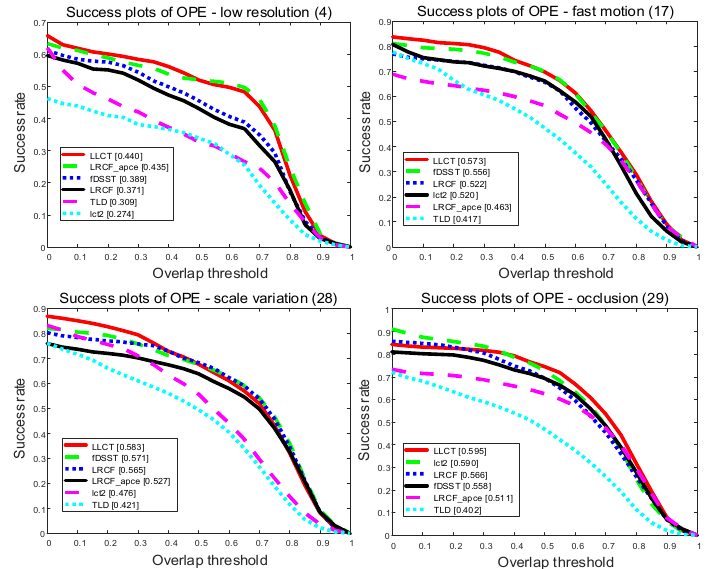
Figure 7. The results of the proposed method and the baseline for different challenging conditions.